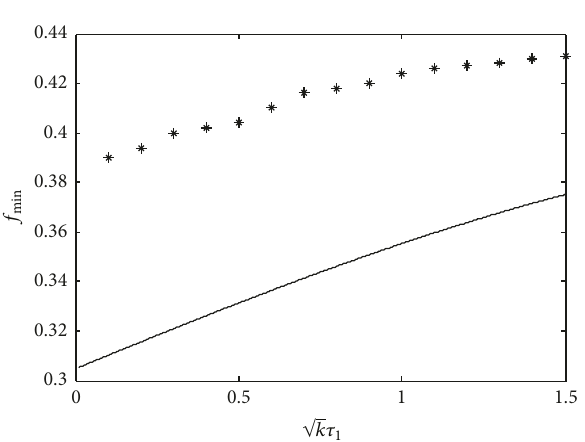
Figure 8: The relation curves of 𝜏 2 and 𝑓 min